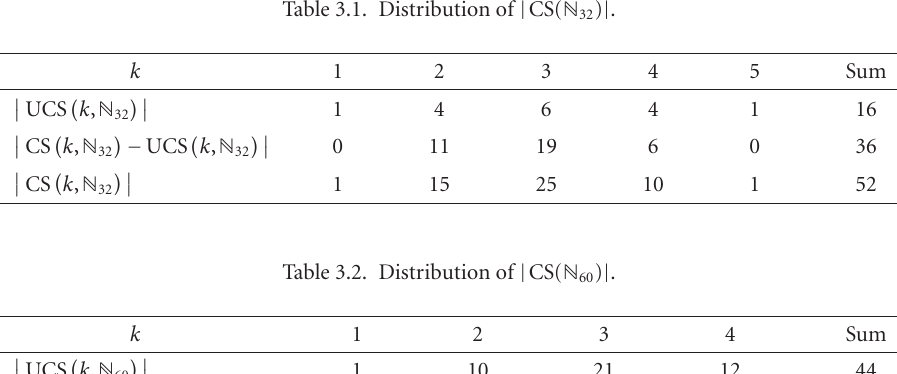
Table 3.1. Distribution of | CS( N 32 ) | .